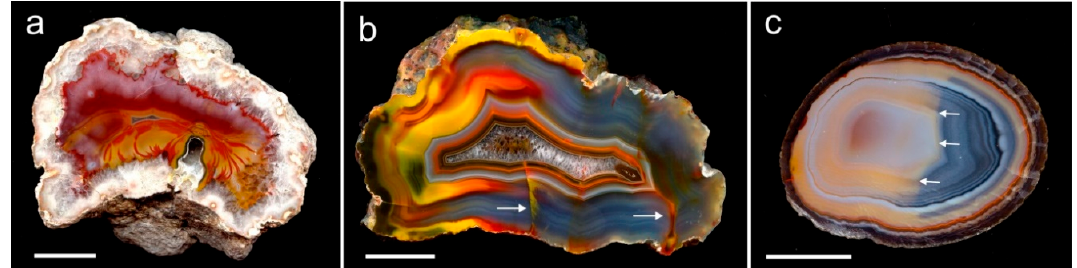
Figure 33. ( a ) Agate from Sierra del Chachahuen, Mendoza (Argentina) without distinct banding and irregular color distribution; ( b ) secondary discoloration (left side and along cracks, see arrows) in an agate from San Rafael, Mendoza (Argentina); ( c ) agate from Xuanhua, province Hebei (China) with effects of secondary bleaching and discoloration; scale bar is 2 cm.